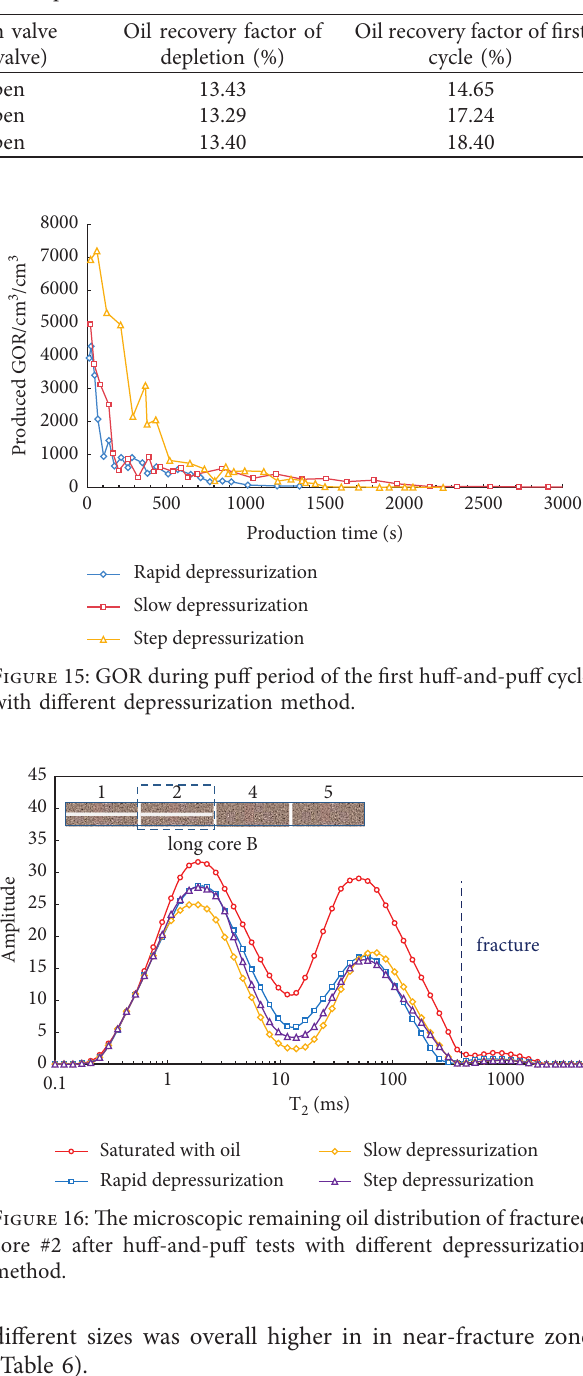
Table 5: Production status of different depressurization methods.